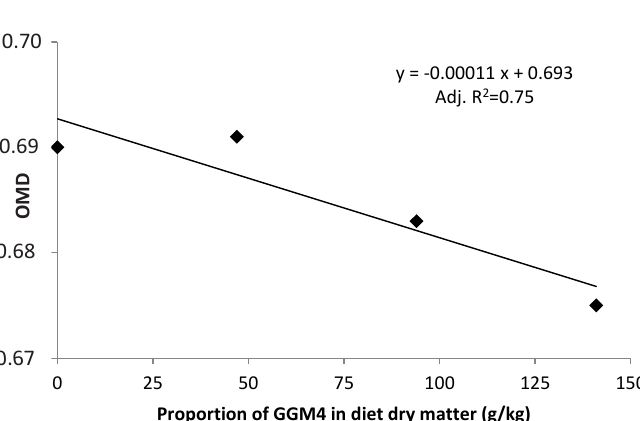
Fig. 2. In vivo organic matter digestibility (OMD) in sheep of diets based on grass silage and galactoglucomannan (GGM4) in varying proportions in Exp. 2.